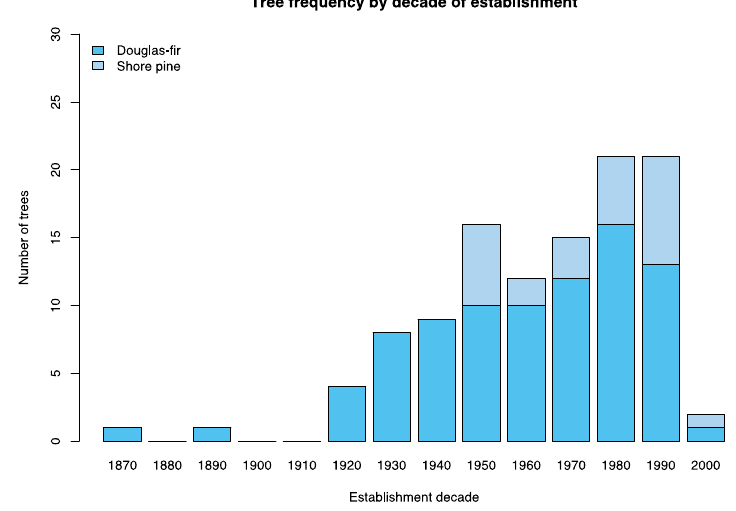
Figure 3. The number of Douglas-fir (dark blue) and shore pine (light blue) trees along with their decade of establishment from every fifth tree (greater than 15 cm diameter at breast height [dbh]) sampled from seven belt transects.